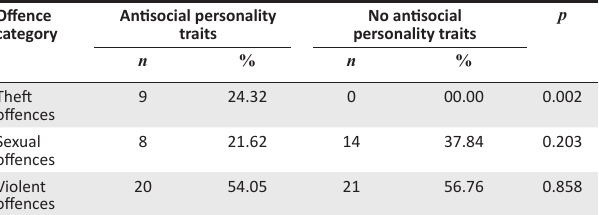
TABLE 2: Prevalence of groups of offences amongst State patients with and without antisocial personality traits. Offence category